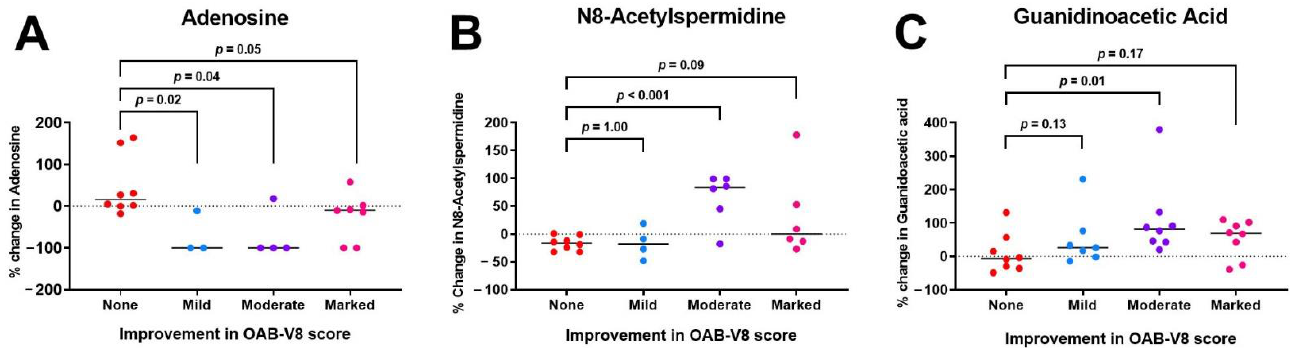
Figure 1. Patient flowchart with time of initial recruitment, BTX-A injection, and follow up.